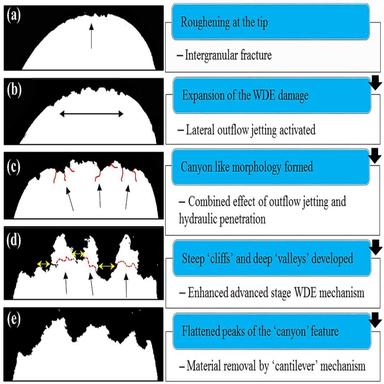
Evolution of rain erosion at the leading edge of Ti-6Al-4V turbofan blades.